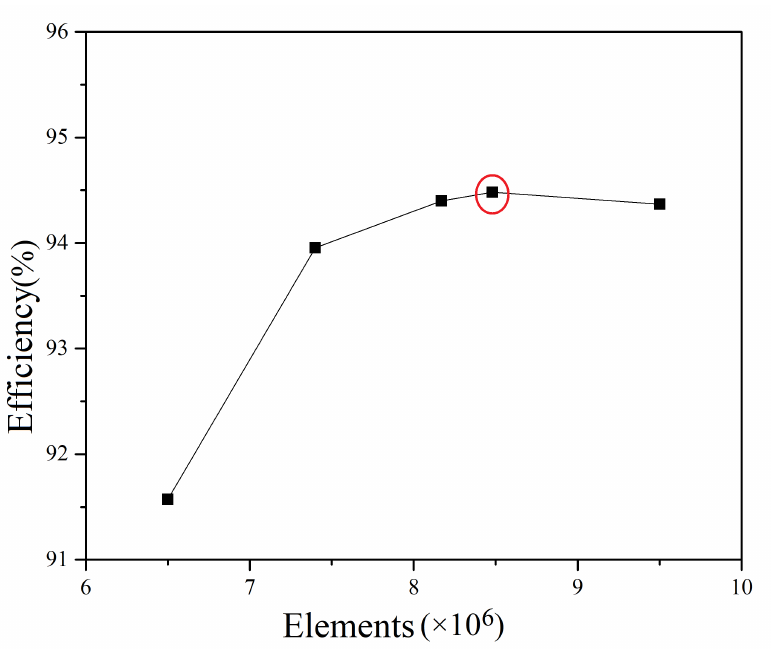
Figure 8. Mesh independence analysis.